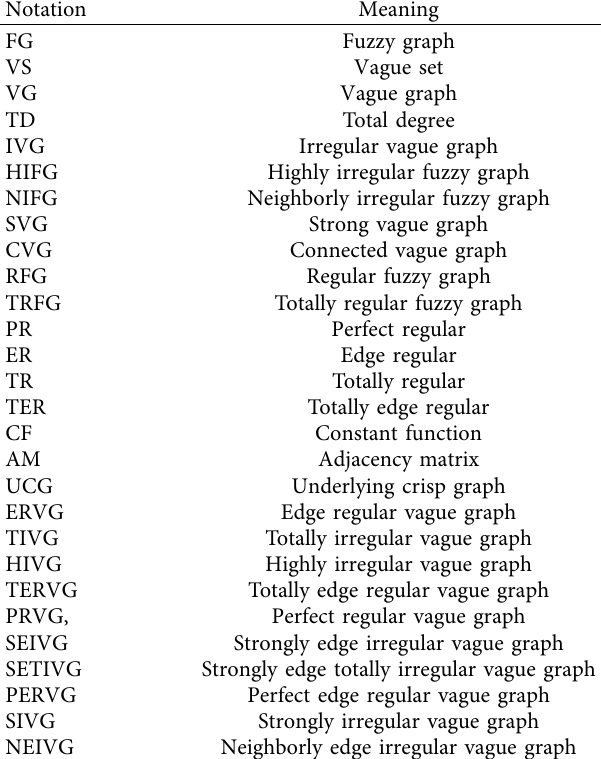
Table 1: : Some basic